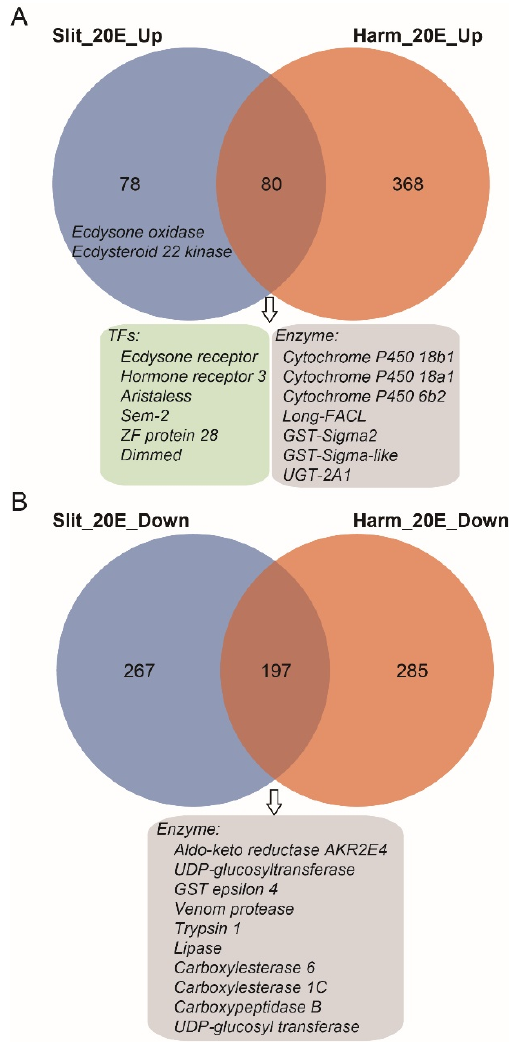
Figure 5. Venn diagram of differentially expressed genes (DEGs) between S. litura and H. armigera . ( A ) The overlaps of significantly up-regulated gene dataset. ( B ) The overlaps of significantly down- regulated gene dataset. The blue and orange circles represent the gene dataset of S. litura and H. armigera , respectively. Some genes from overlap gene sets were listed in box.